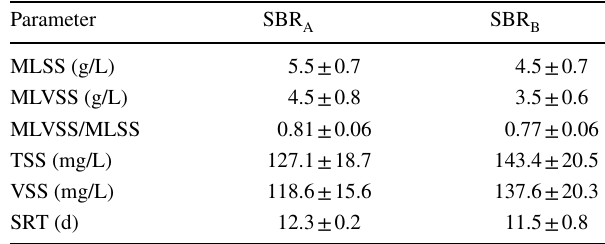
Table 1 Average values of biomass properties for SBR